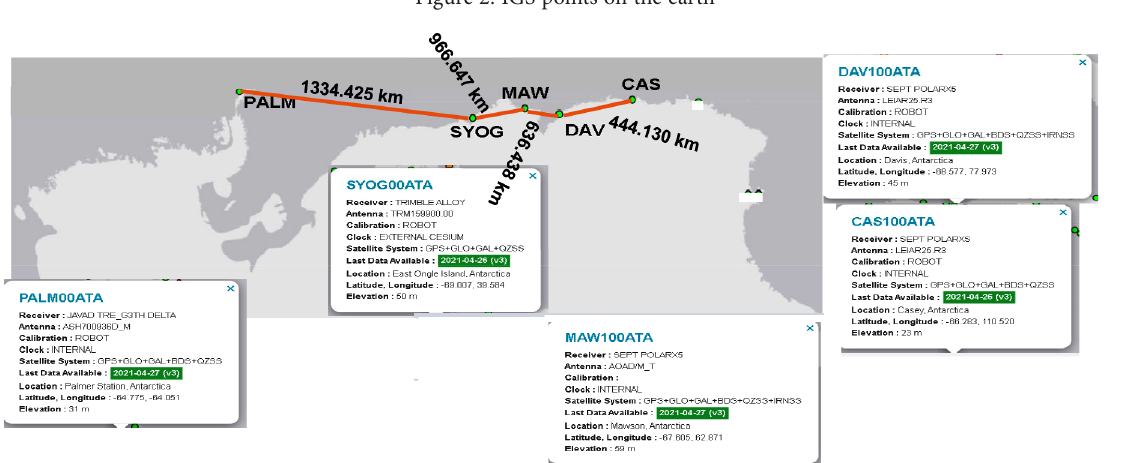
Figure 3. The specifications of the five IGS points nearby the South Pole Region (PALM, SYOG, MAW, DAV and CAS